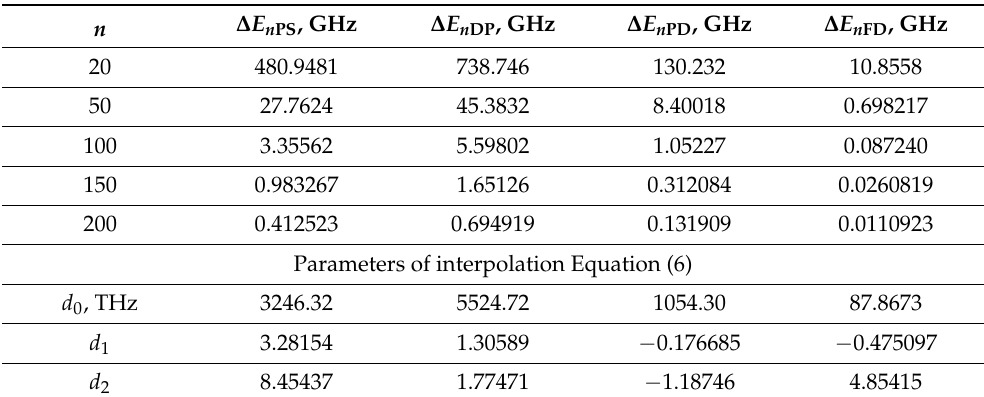
Table 3. Frequencies of electric dipole transitions in Na atoms: from state n P 3/2 to the n S 1/2